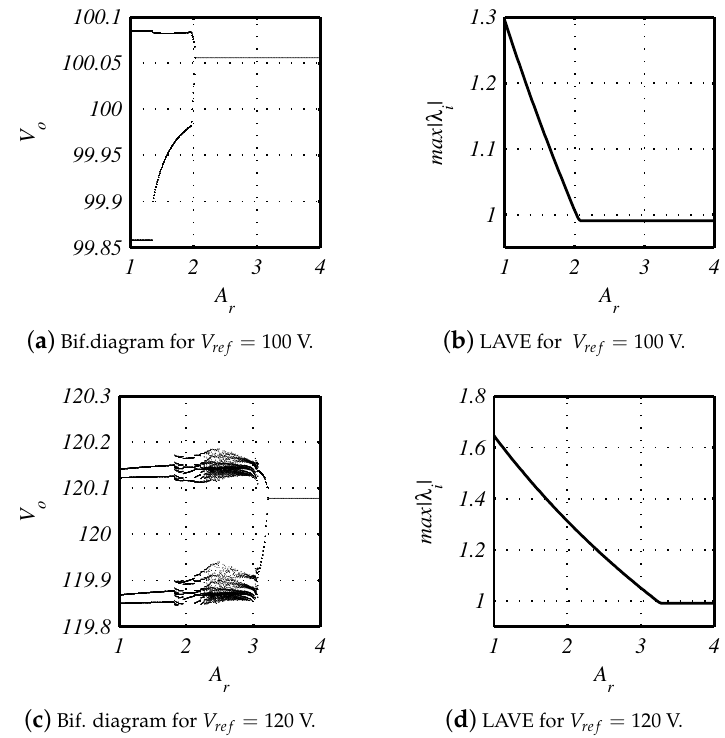
Figure 5. Bifurcation diagrams and largest absolute value of eigenvalues (LAVE) evolution for A r